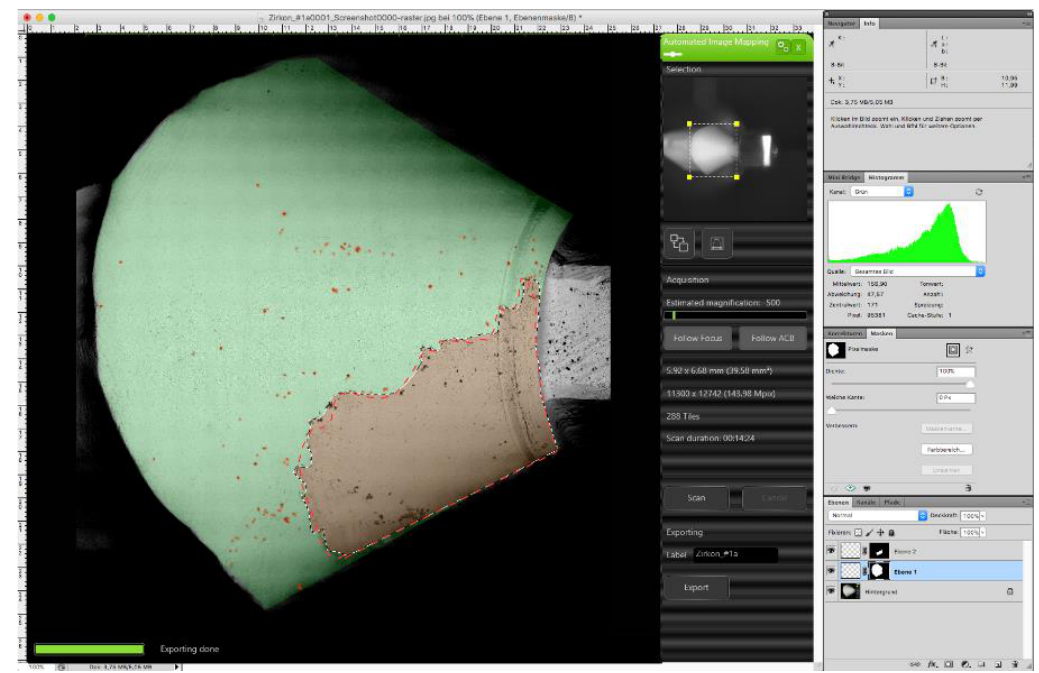
Figure 3. Computerized planimetric calculation of the proportion between area covered with contaminants (red) and the total surface of the abutment shoulder displayed (green).